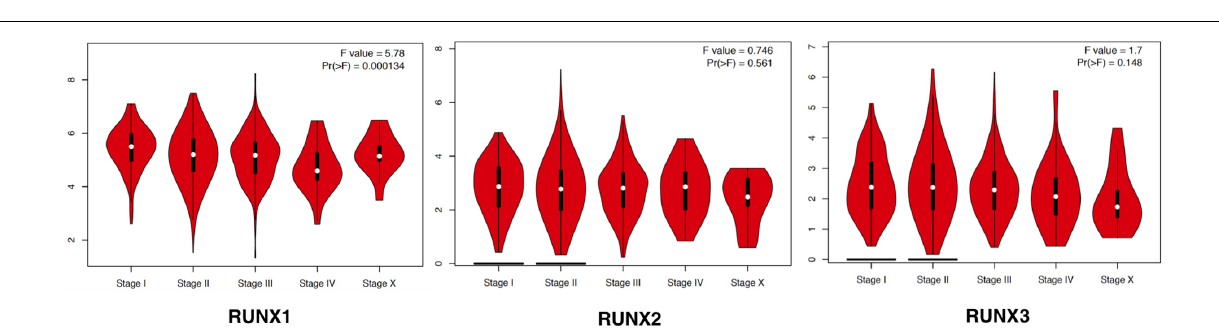
FIGURE 2 | Correlation between RUNX expression and tumor stage in breast cancer patients. The transcriptional levels of RUNX1, RUNX2, and RUNX3 in different stages of breast cancer were